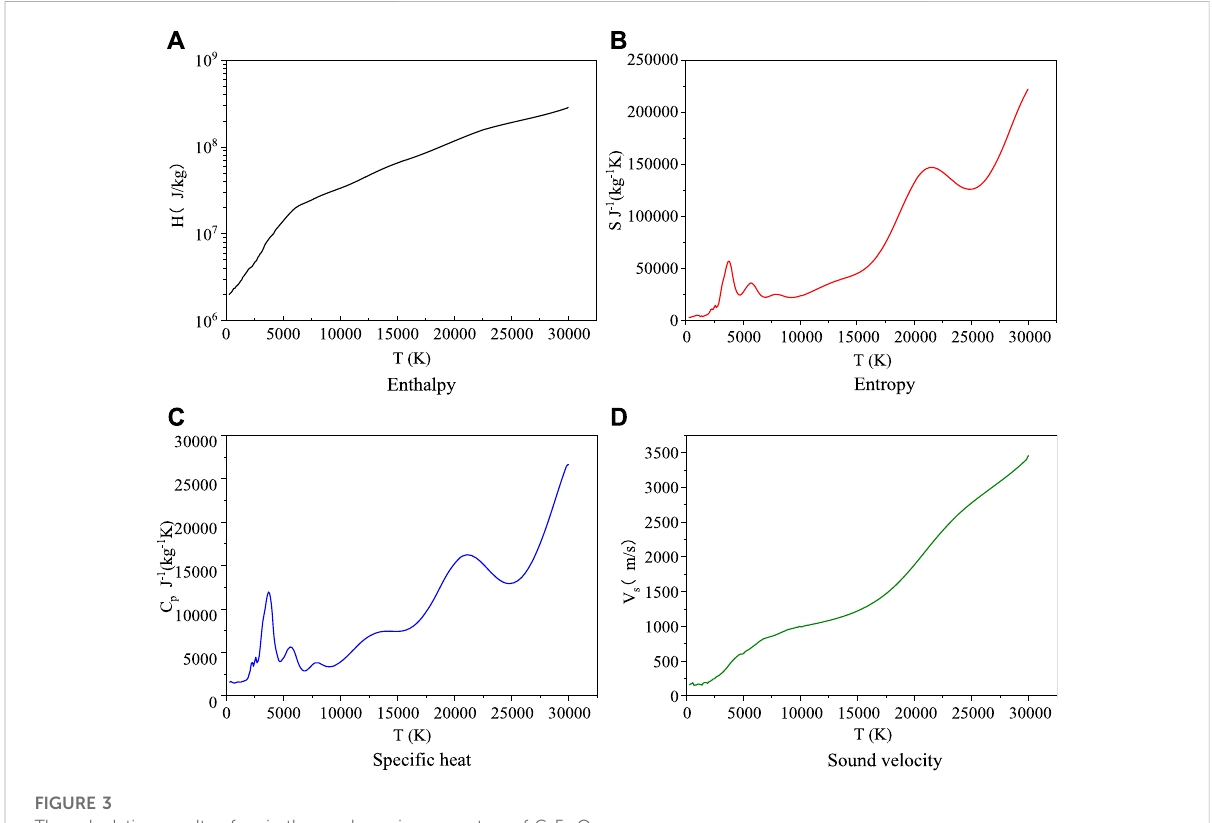
FIGURE 3 The calculation results of main thermodynamic parameters of C 6 F 12 O.